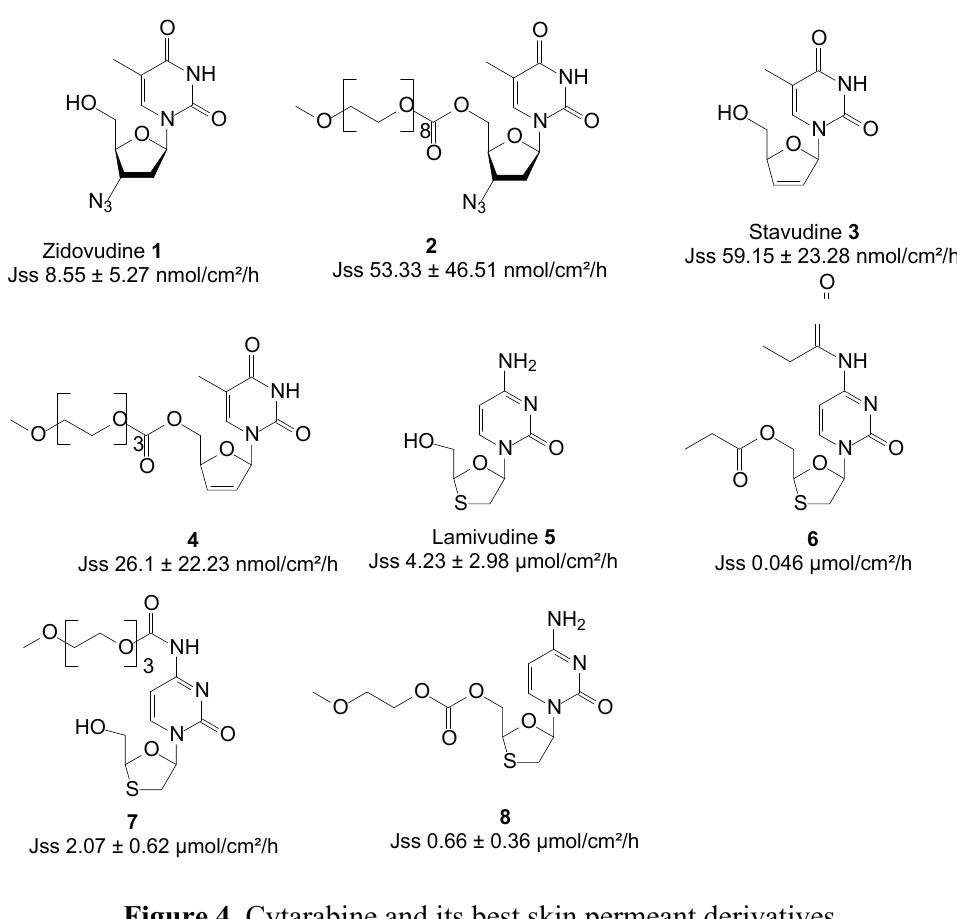
Figure 3. Structures of ARV drugs and best skin penetrant derivatives.